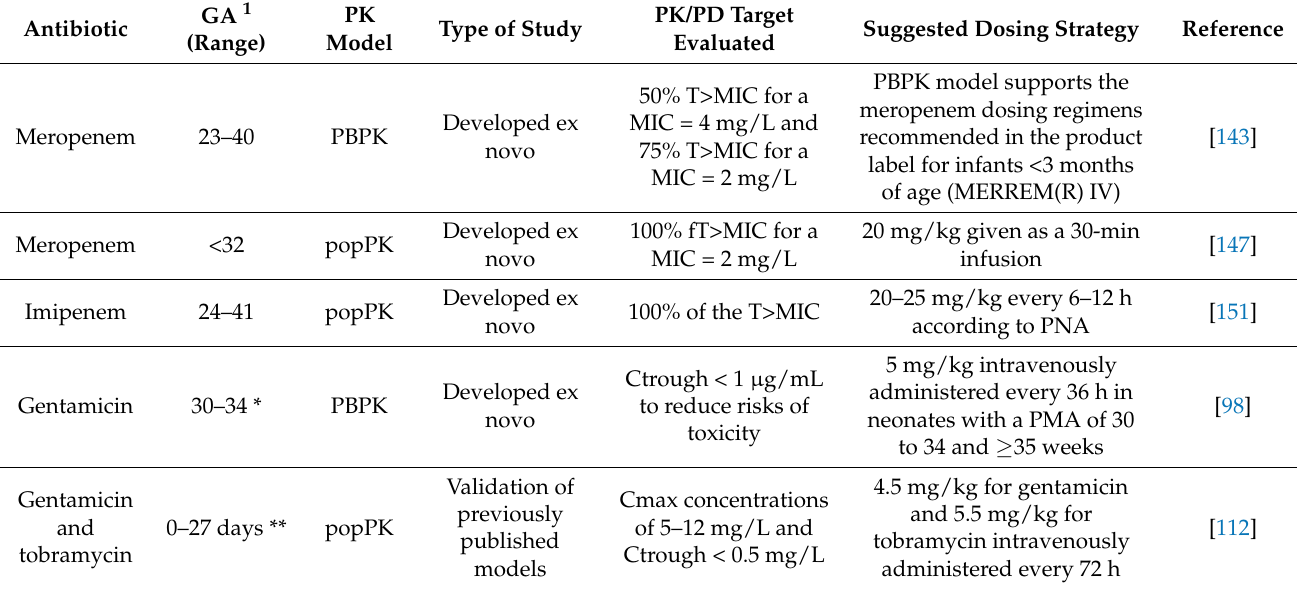
Table 2. Antibiotics’ PK studies conducted on preterm